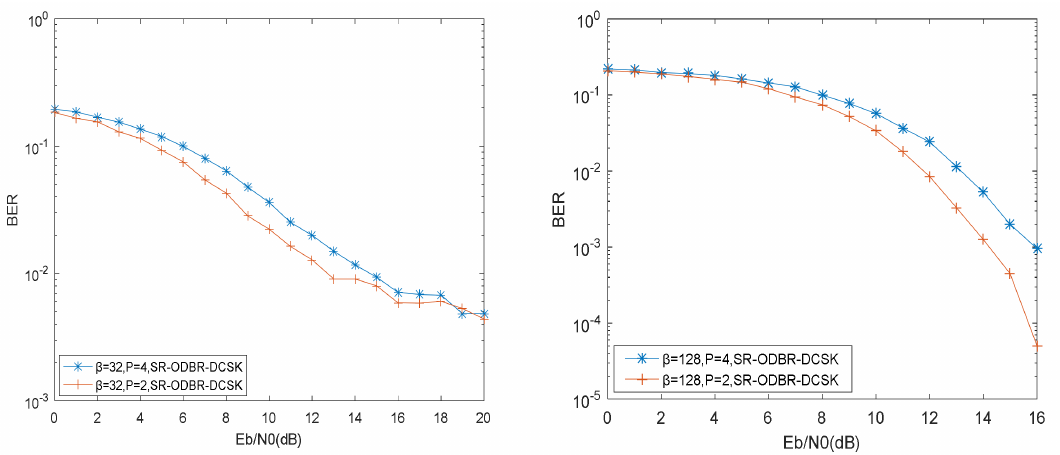
Figure 6. Effects of different P s on the SR-ODBR-DCSK system error performance. ( a ) β = 32; ( b ) β =